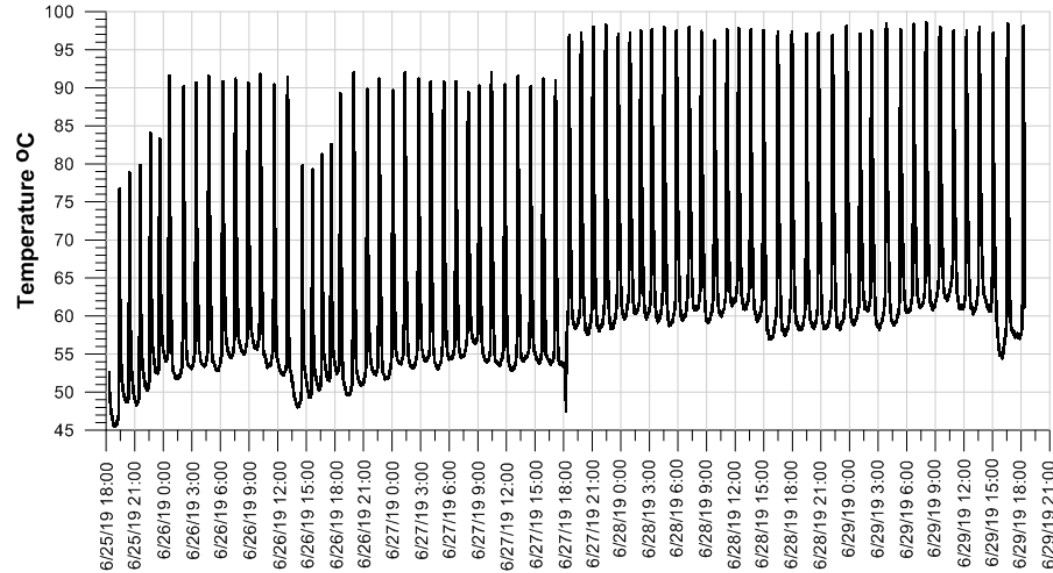
Figure 4. Shaman geyser temperature cycling records obtained at the bottom of the conduit (depth of 2.9 m) during the time period of observations from 25.06.2019 18:00 to 29.06. 2019 18:00 (73 eruptions, 78.4 min). Note that a 5 °C temperature positive shift after the casing tube was removed on 27 June 2019 18:00.